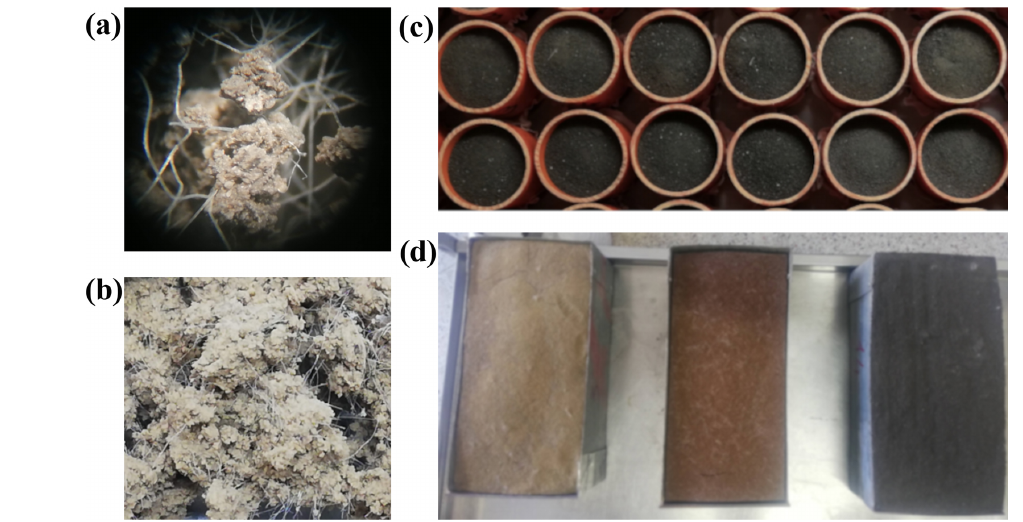
Figure 1. (a,b) Contaminated soils. (c) Experimental units in experiment I. (d) Experimental units in experiment II.